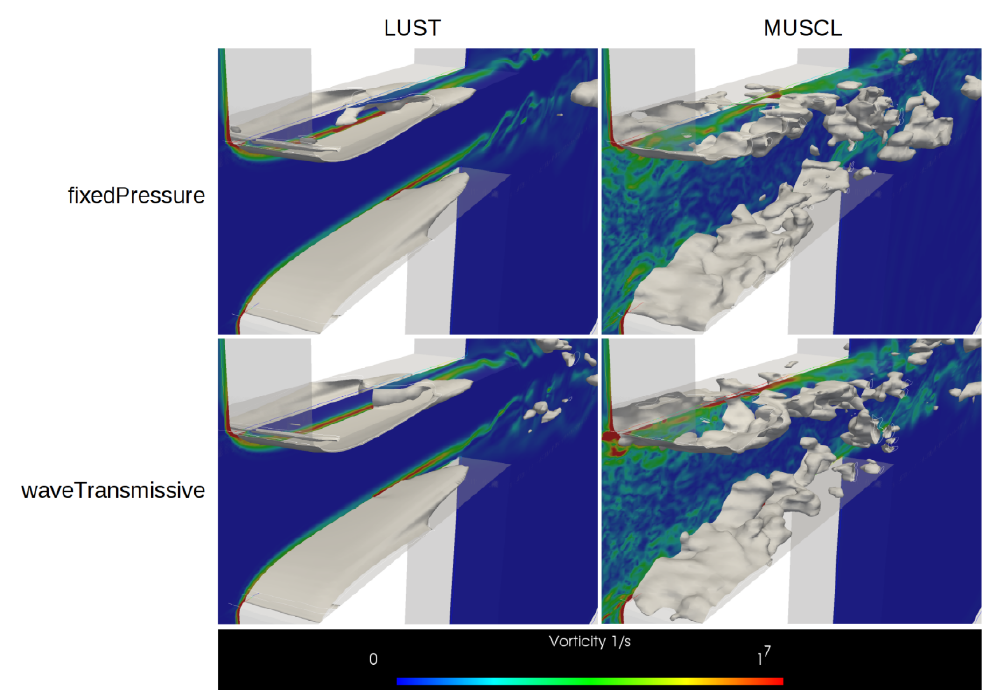
Figure 10. Colour distribution of the instantaneous vorticity, taken from all velocity components throughout the centre of the nozzle for LUST and MUSCL at 8.5 MPa with 12 mm geometry with a vapour contour superimposed at vapour fraction of 0.5.